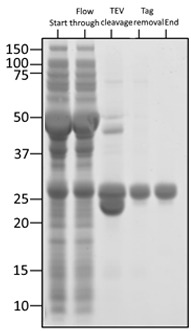
Purified RhoGDI protein.Coomassie stain of 12% SDS-PAGE to assess purity of RhoGDI purified from bacteria; lane 1: start, lane 2: flow through, lane 3: TEV cleavage, lane 4: tag removal, lane 5: end product after gel filtration.